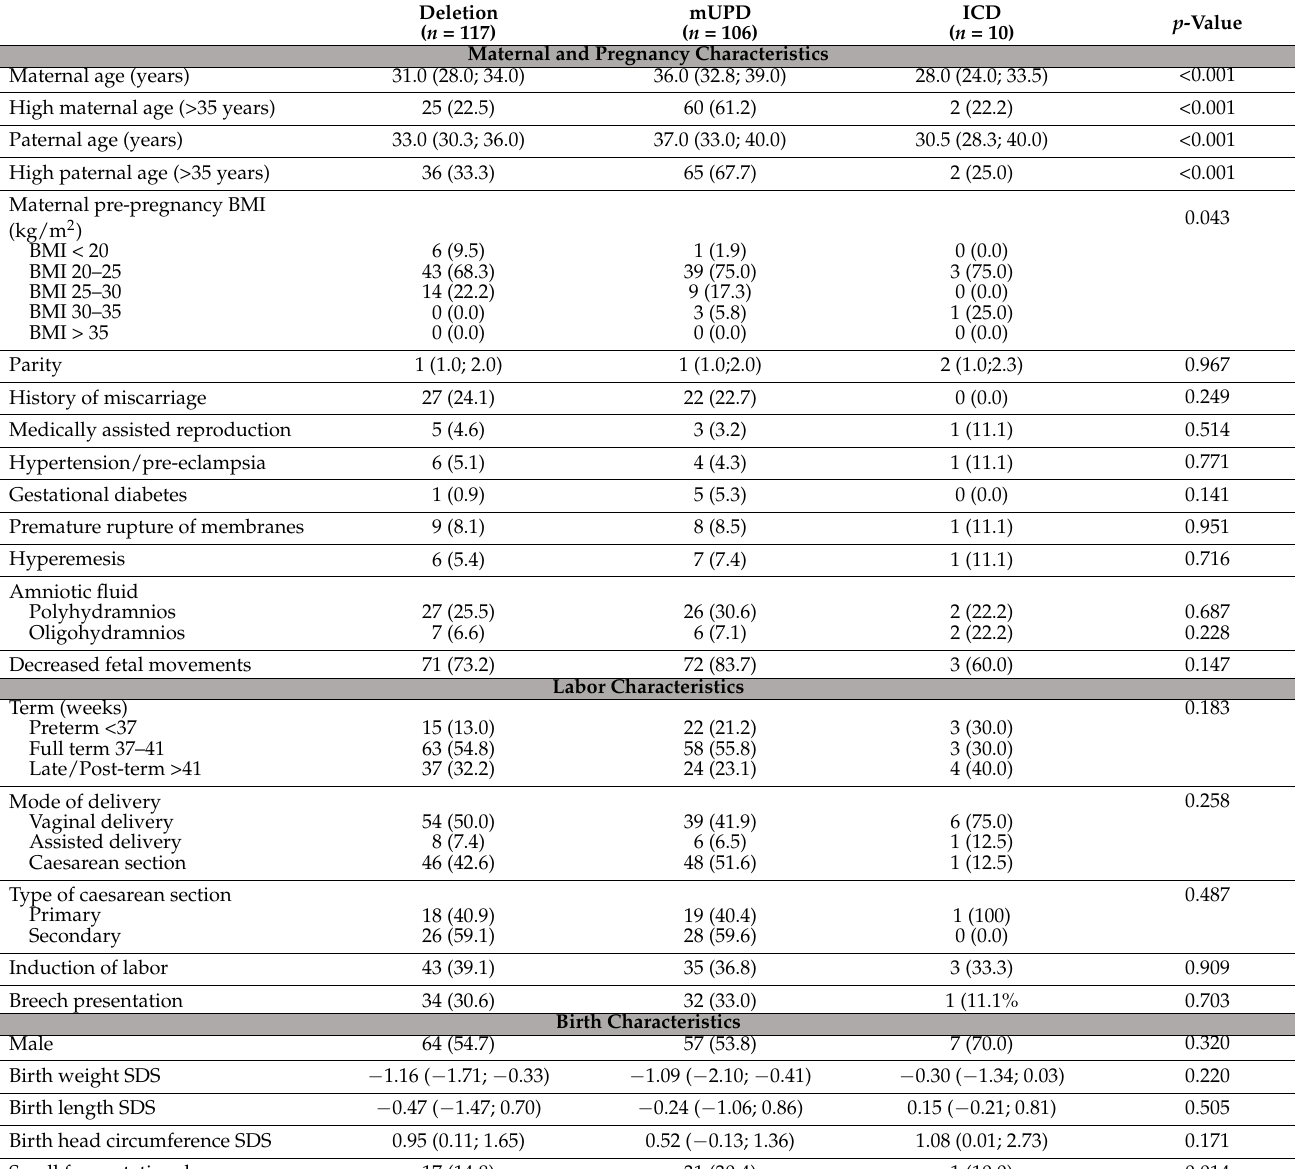
Table 2. Characteristics of the PWS genetic